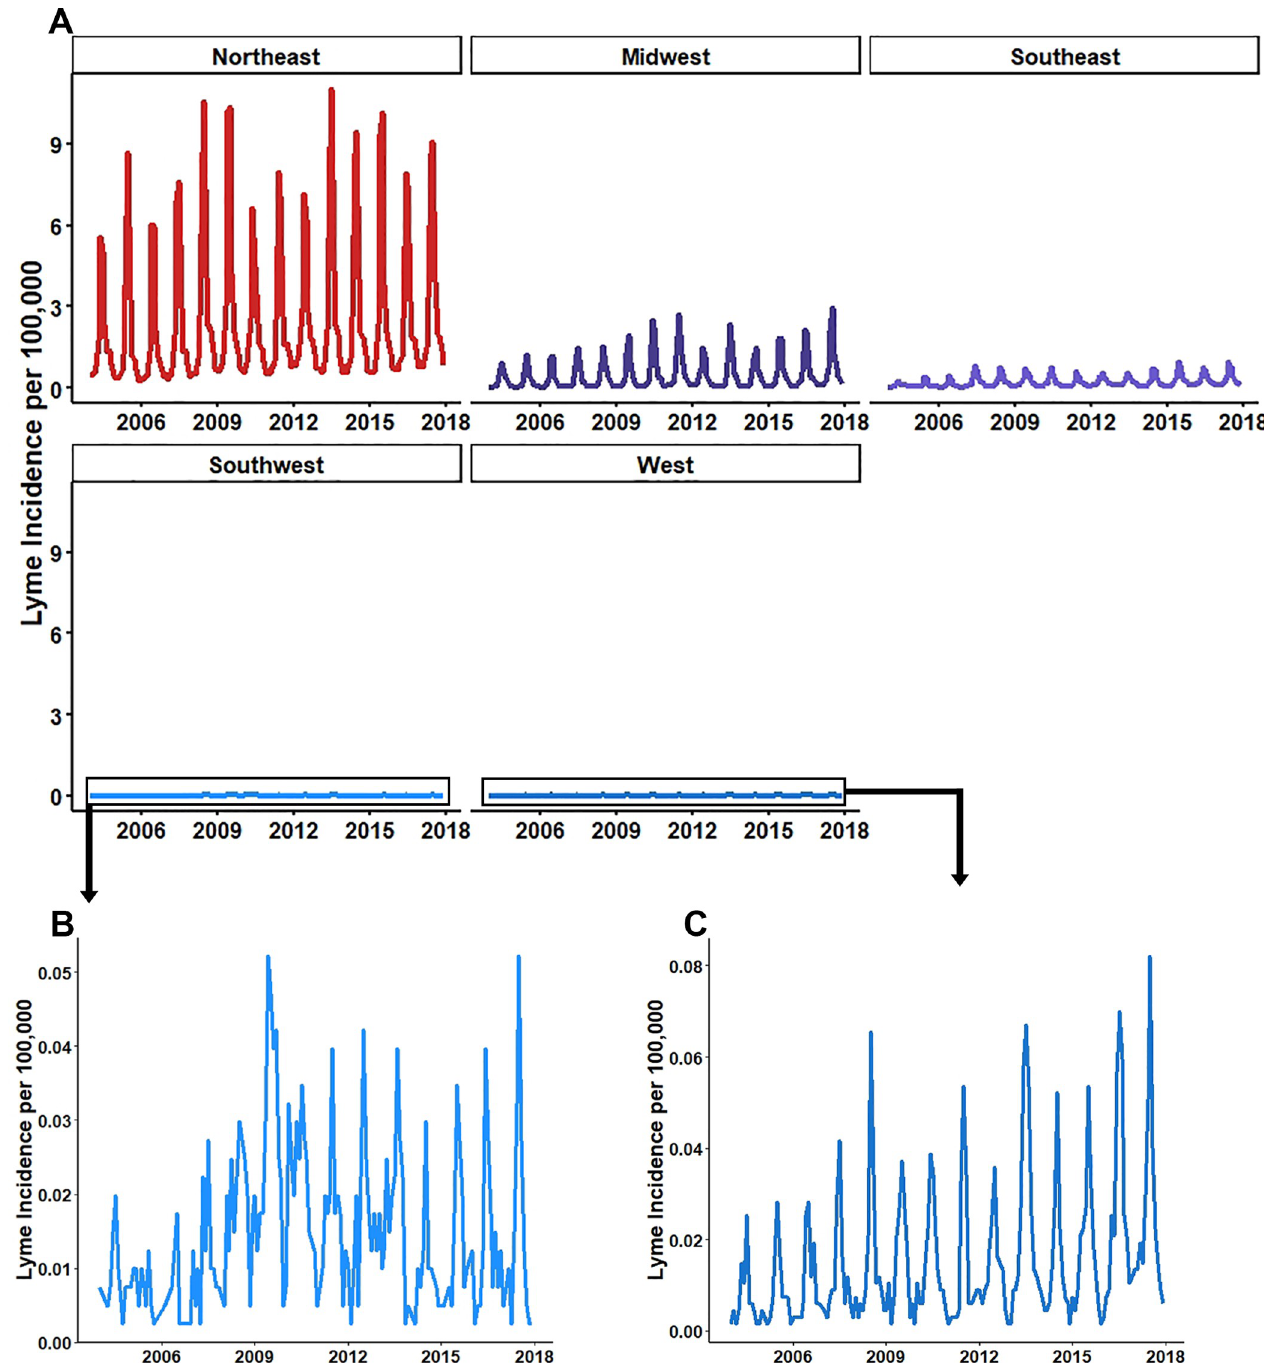
Fig 3. Regional Lyme disease incidence. (A) All regions relative to Northeast incidence rates, (B) Southwest, (C) West. Incidence rates calculated by summing monthly state incidence from CDC surveillance in each region. Denominator values calculated from 2010 US Census state populations and aggregated to region. Calculations and graphs made using RStudio version